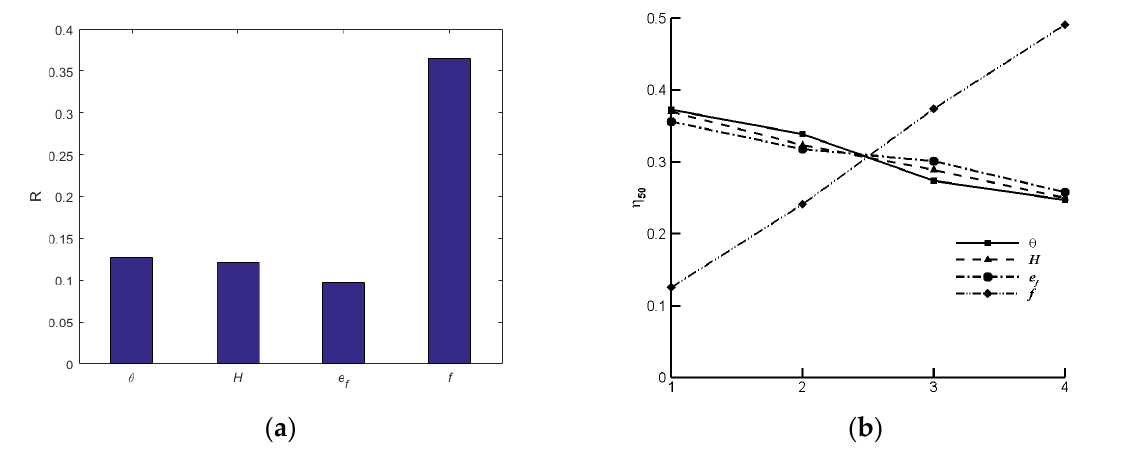
Figure 13. Range and impact of various parameters on   . ( a ) Range. ( b ) Influence